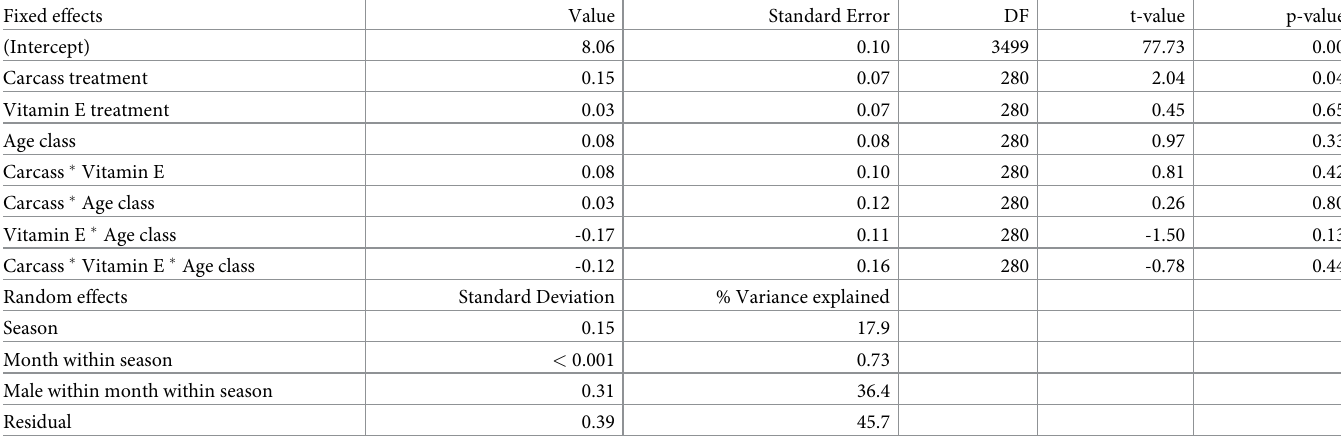
Table 1. Model parameters from the fitted linear mixed effects model for FGM.